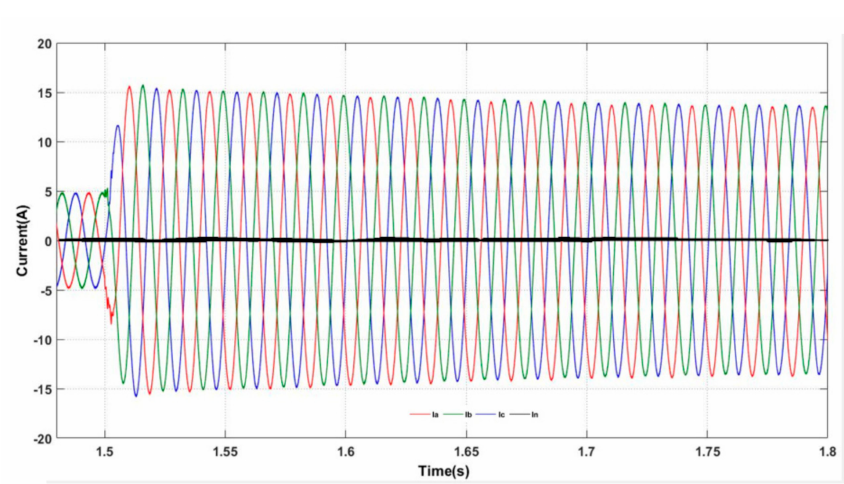
Figure 22. Power variation of nonlinear load.